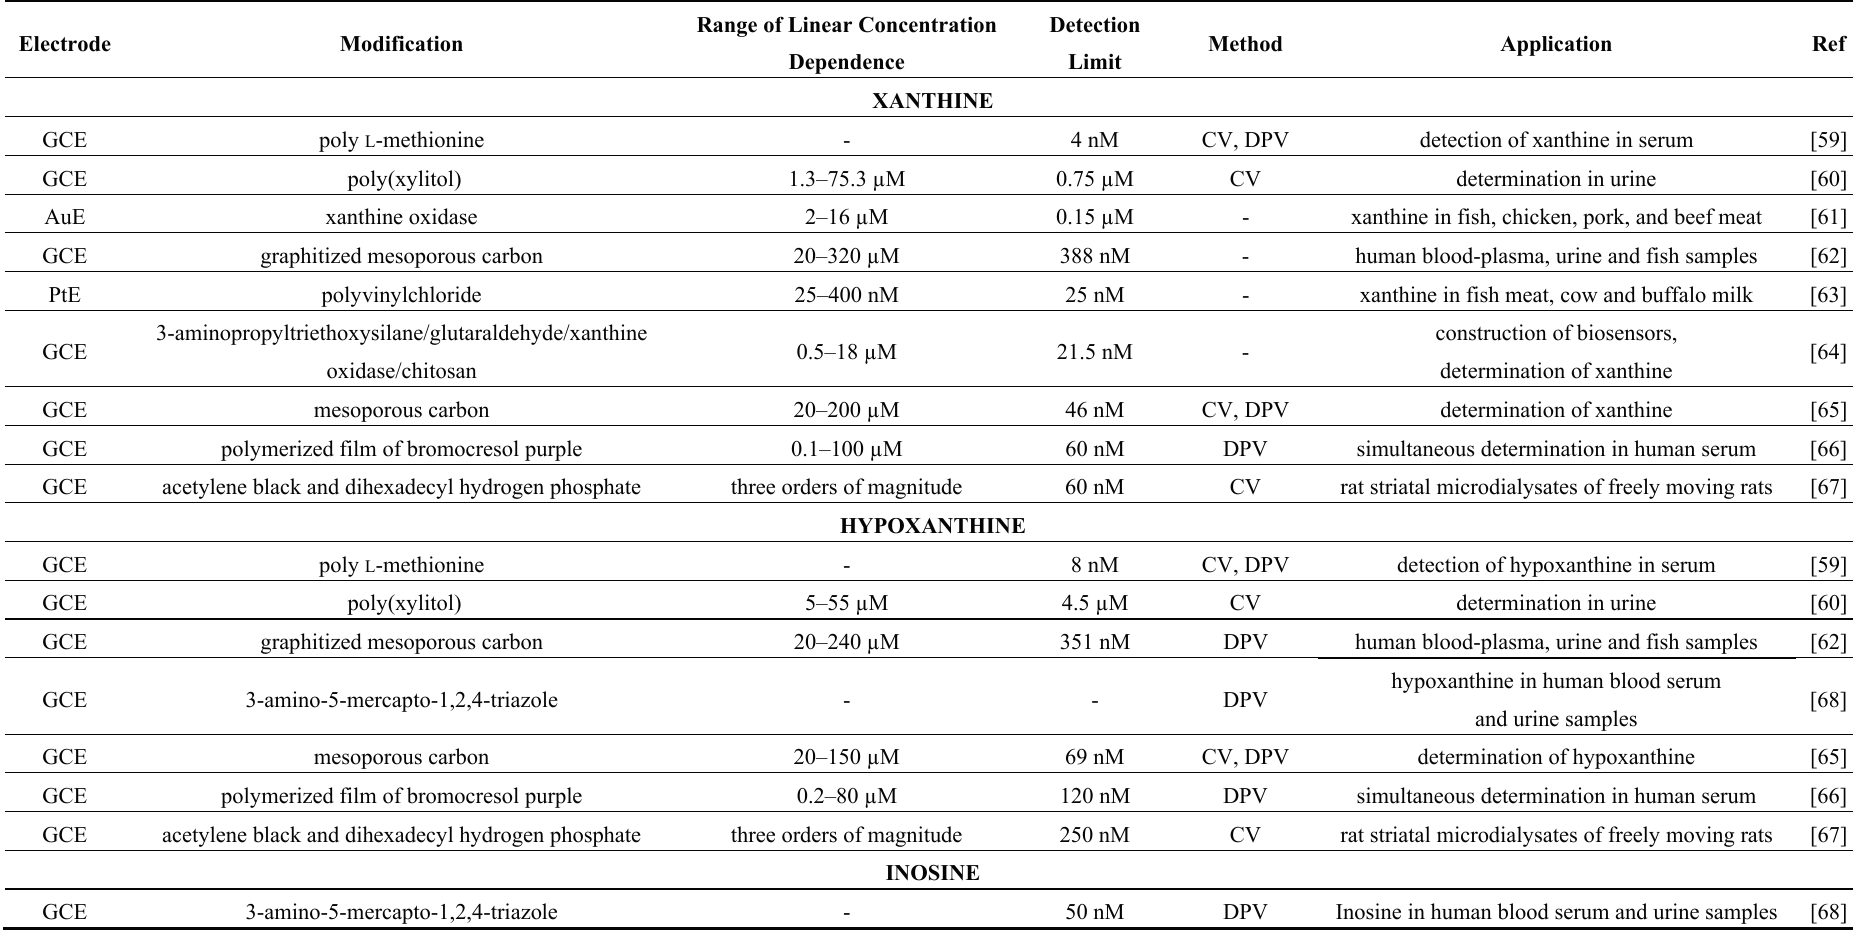
Table 3. Xanthine and